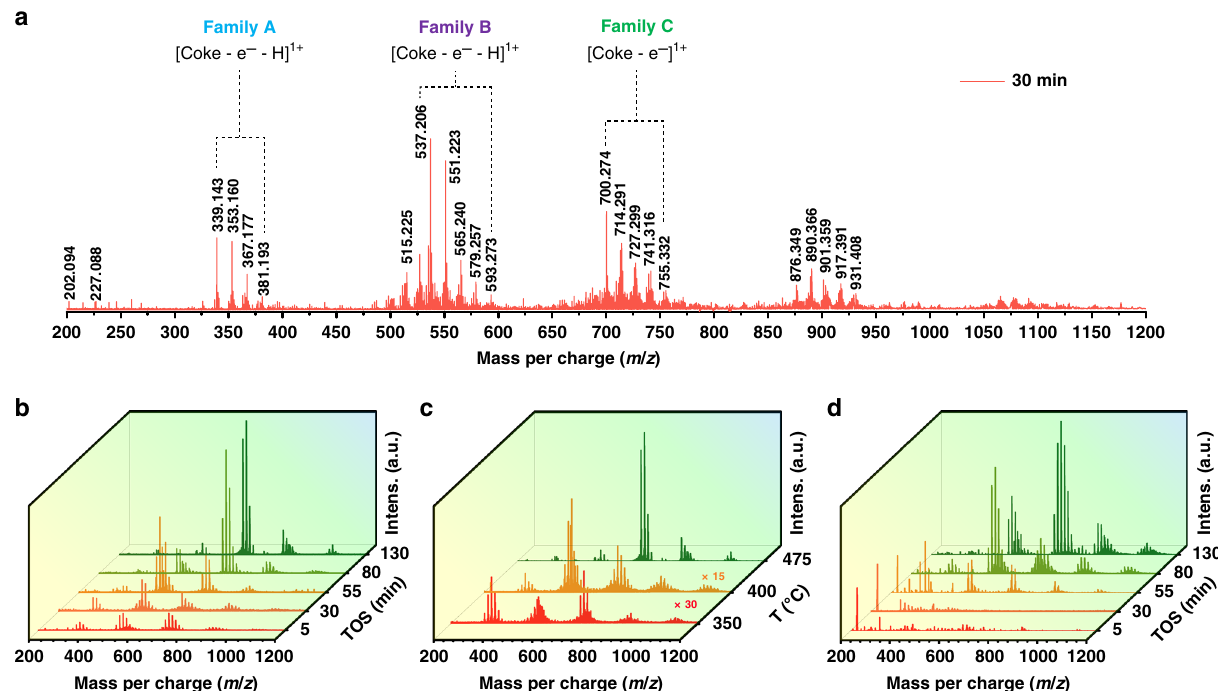
Fig. 3 MALDI FT-ICR mass spectra of the liberated carbonaceous deposits. The mass spectra of the liberated carbonaceous deposits obtained from the used up-layer SAPO-34 catalysts by HF dissolution-CCl 4 extraction after MTO reaction with WHSV of 4 h − 1 at 475 °C for 30 min ( a ), at 475 °C for different durations (5 – 130 min) ( b ), at different temperatures (350 – 475 °C) ( c ). d The mass spectra of the liberated carbonaceous deposits obtained from the used bottom-layer catalysts after MTO reaction at 475 °C for different durations (5 – 130